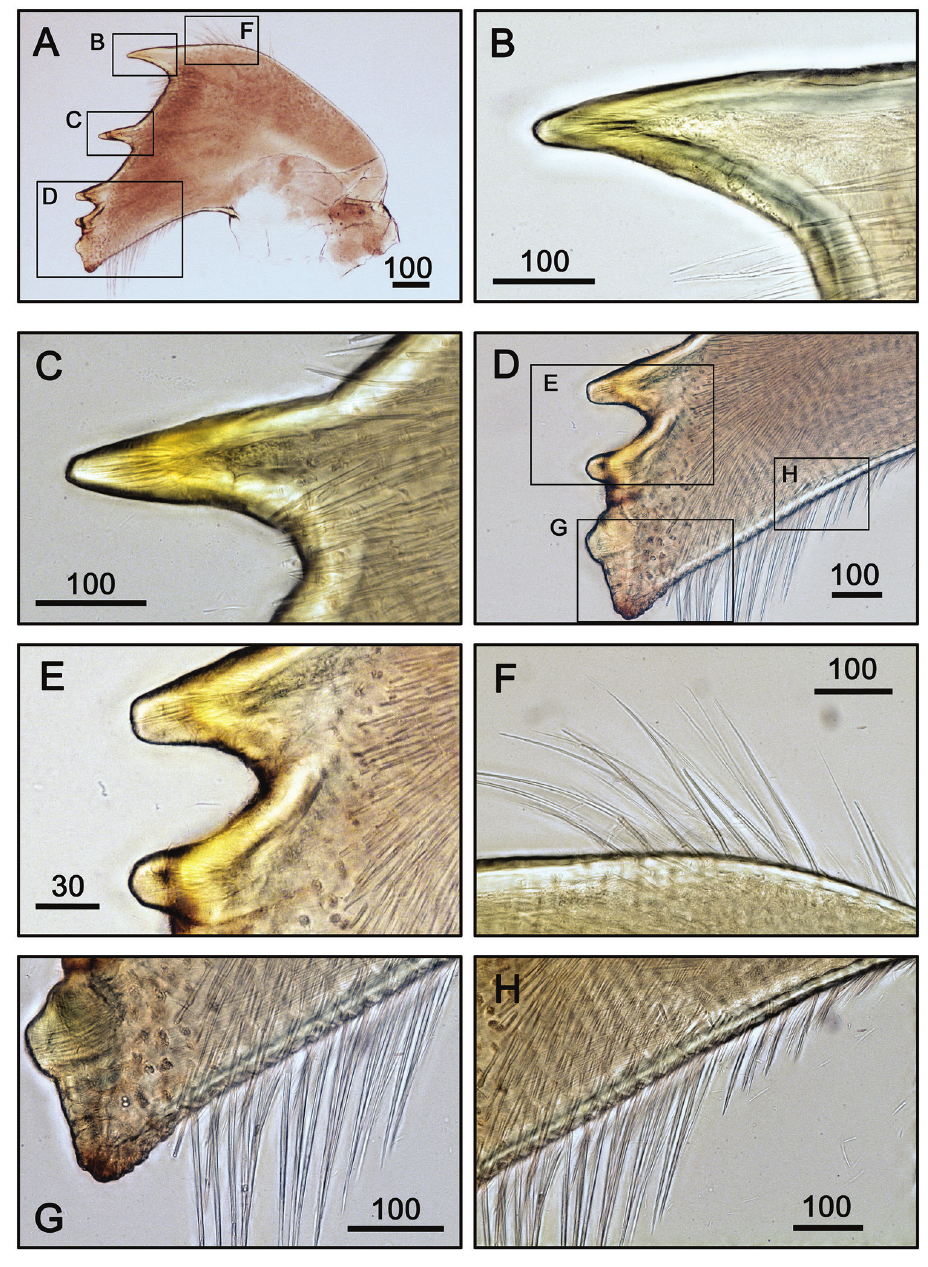
Figure 5. Mandible of Galkinius maculosus sp. n. A Mandible (ASIZCR000343) B First teeth of man- dible C Bidentate second tooth D Lower margin and inferior angle with simple setae E Bidentate third and fourth teeth F simple setae on lateral margin G Inferior angle with simple setae H Lower margin with simple setae. Scale bars in